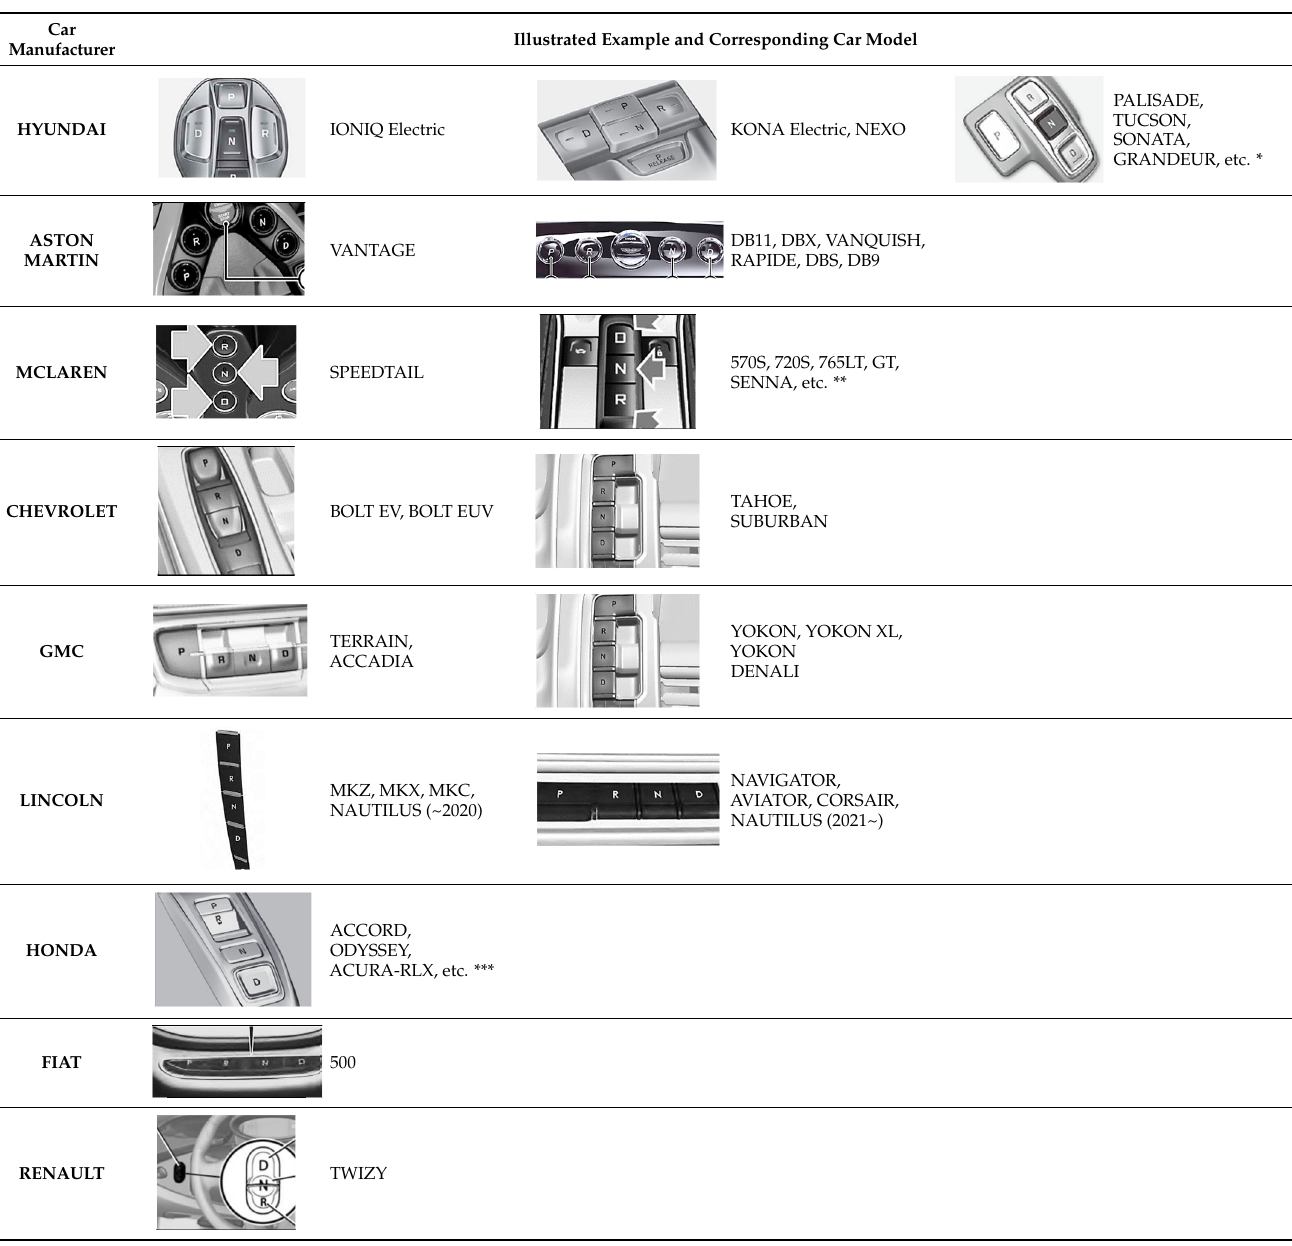
Table 1. Different types of electronic shift button layouts according to car manufacturer/model. Illustrated Example and Corresponding Car Model